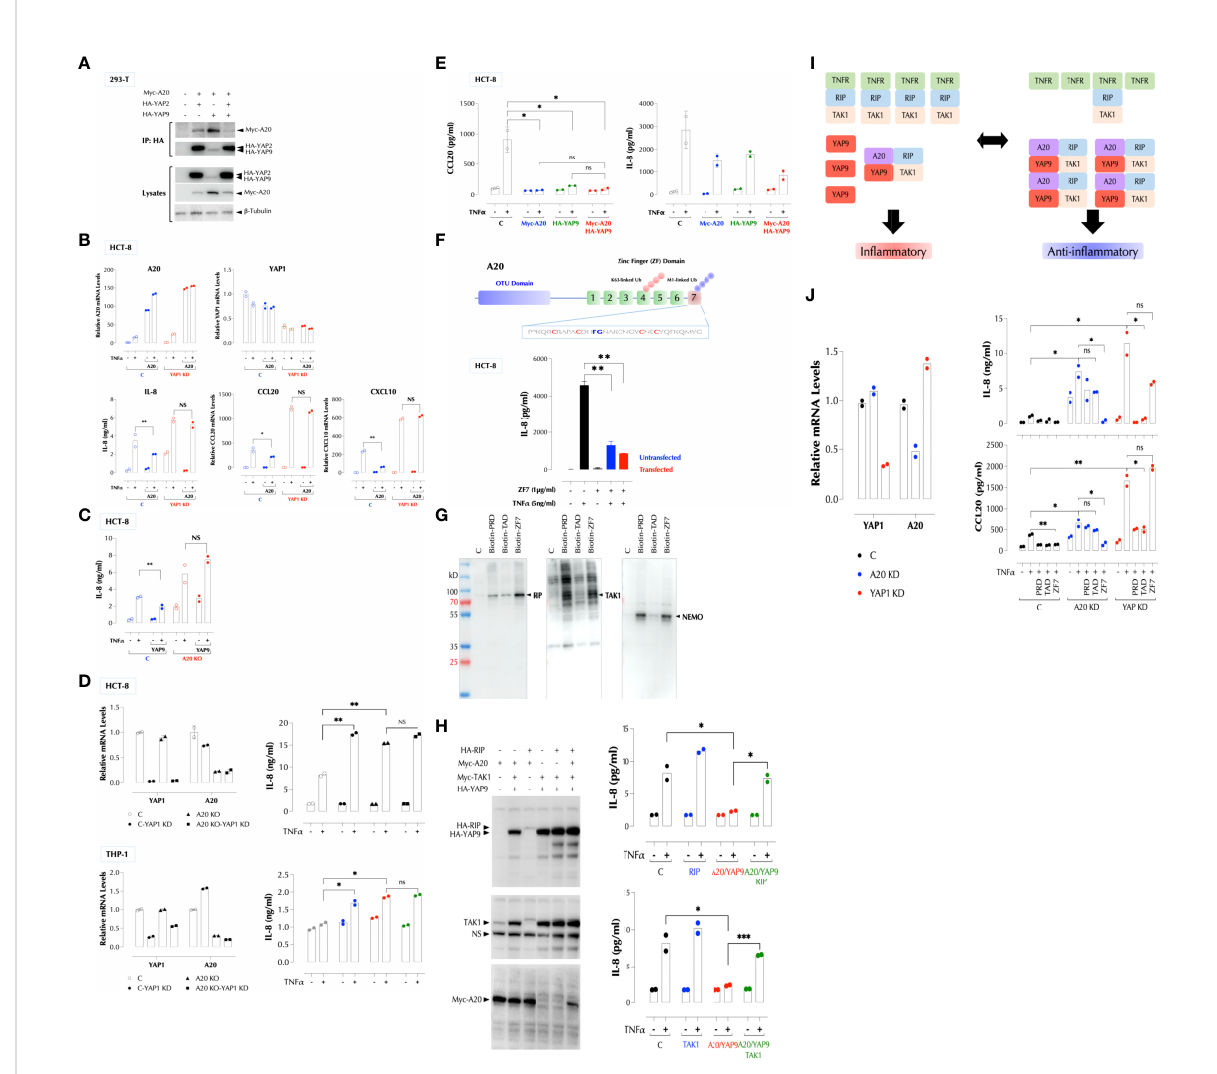
FIGURE 6 YAP1 and A20 collaboratively suppress the in fl ammatory responses. (A) YAP proteins constitutively interact with A20 and YAP9 has a higher af fi nity to A20 than YAP2. 293-T cells were transfected with the indicated expression constructs and immunoprecipitation (IP) and western blotting were performed as indicated. (B) YAP9 is required for A20 to suppress the TNF response. C and YAP1-KD HCT-8 cells with or without A20-OE were stimulated with TNF a (2ng/ml) for 2h or overnight for qPCR or IL-8 ELISA, respectively. (C) YAP9 requires A20 to suppress the TNF response. C and A20-KO HCT-8 cells were stimulated with TNF a (2ng/ml) overnight for IL-8 ELISA. (D) YAP1 or A20 single de fi ciency enhances the TNF response as much as YAP1/A20 double de fi ciency. YAP1 KD and/or A20 KO were performed in HCT-8 or THP-1 cells, and qPCR and ELISA were done after stimulation with TNF a overnight. (E) Over-expression of YAP9 or A20 alone suppresses the TNF response as much as YAP1/A20 together. HCT-8 cells were transfected as indicated and stimulated with TNF a (2ng/ml) overnight, followed by IL-8 and CCL20 ELISA. (F) ZF7 peptide in A20 suppresses the TNF response. The indicated ZF7 peptide was biotinylated and added to HCT-8 cells with or without peptide transfection. TNF-induced IL-8 expression was measured by ELISA. (G) PRD, TAD, and ZF7 peptides bind to the TNF signaling components, RIP, NEMO, and TAK1. Biotinylated peptides were used to pulldown cellular targets from HCT-8 total cell lysates. The results are a representative of 3 experiments. (H) RIP or TAK1 OE overcomes the A20/YAP9-mediated suppression of the TNF response. HCT-8 cells were transfected and stimulated with TNF a (2ng/ml) overnight, followed by IL-8 ELISA. (I) A stoichiometry model of YAP9/A20-mediated suppression of the TNF response. As A20 is induced by in fl ammatory stimuli, the number of A20-YAP9 complex increases, shifting the balance from in fl ammatory to anti-in fl ammatory response. (J) PRD and TAD require A20 to suppress the TNF response while YAP1 must be present for ZF7 to do the same. HCT-8 cells were transfected with the indicated siRNA and stimulated with TNF a (2ng/ml) overnight with the indicated peptides for IL-8 and CCL20 ELISA. * P < 0.05, ** P < 0.01, *** P < 0.001, ns, not signi fi